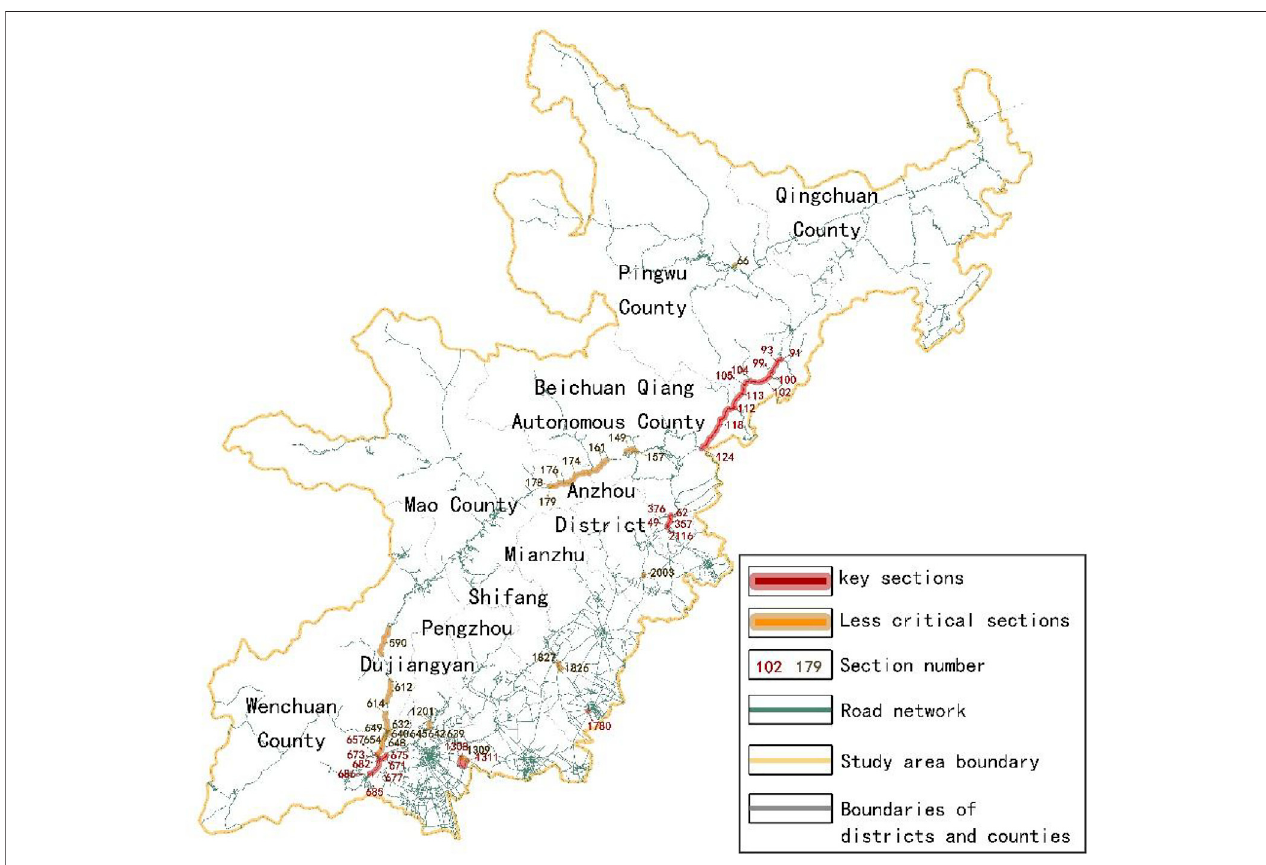
FIGURE 15 | Spatial distribution of key sections and more critical sections.